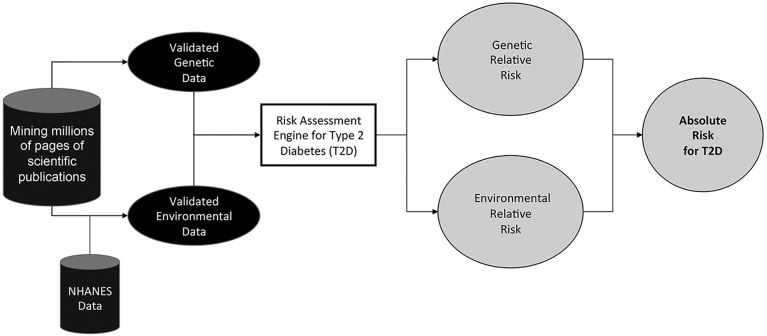
Illustration of the RAE used to assess the risk of type 2 diabetes in the MDC-CC.In this study, T2D relative environmental and genetic risks are used.